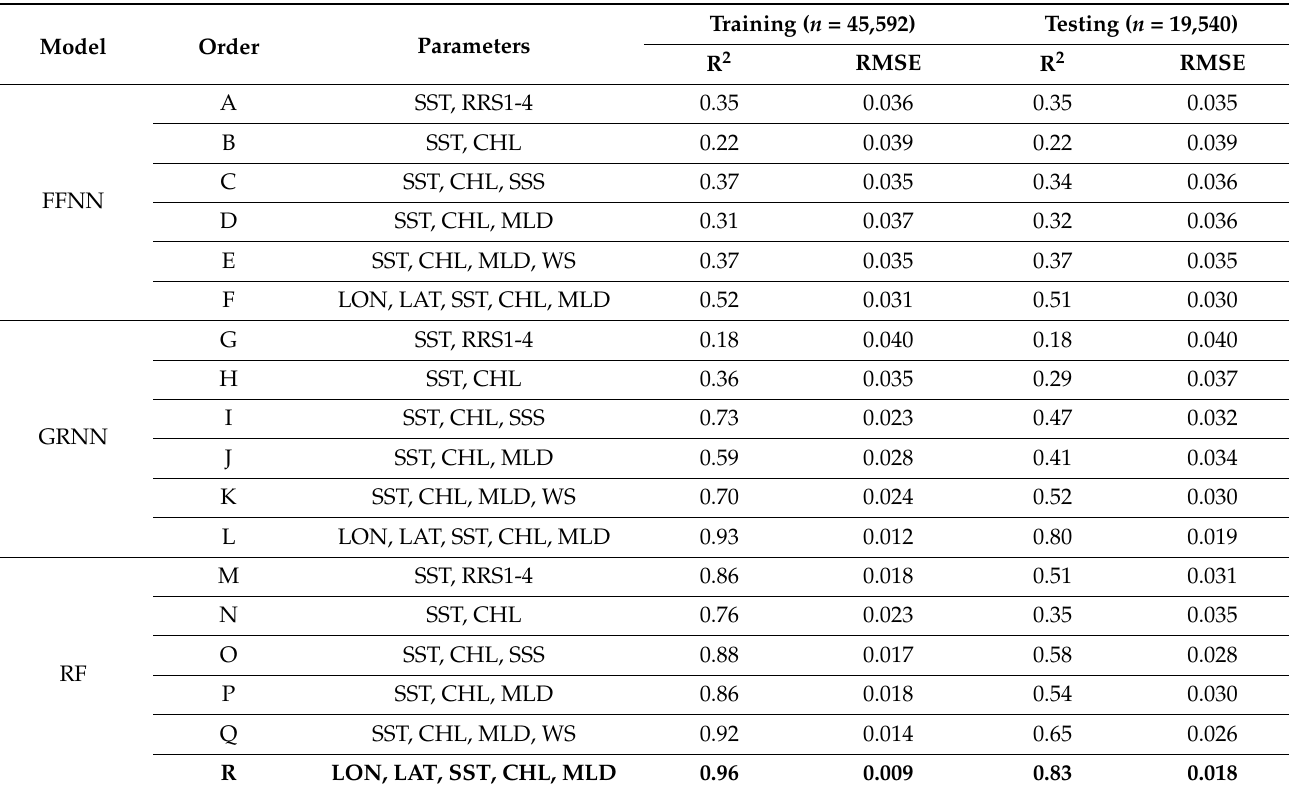
Table 4. Training and testing results of 18 sets of pH inversion